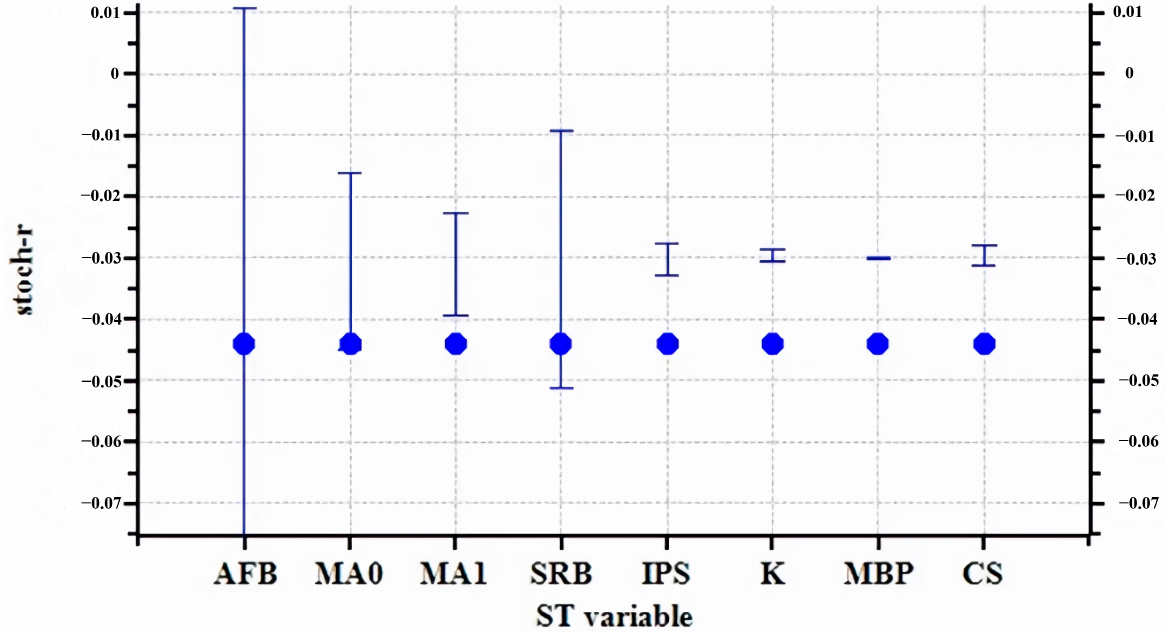
Figure 2. Sensitive analysis to stoch-r (AFB: adult females breeding; MA0: mortality from age 0 to 1; MA1: mortality from age 1 to 2; SRB: sex ratio at birth; IPS: initial population size; K: carrying capacity; MBP: males in breeding pool; CS: catastrophes severity. A Max-Min plot shown the range of results for each tested variable, averaged across the values of all other tested variables. A point was placed at the result for the base scenario. In a Max-Min plot, the variables with the longest lines had the greatest effect on results.).